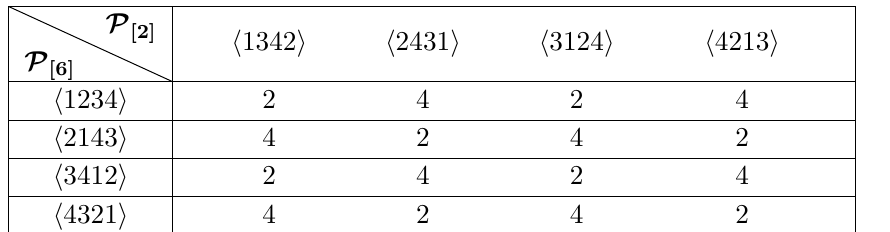
Table 8. {P} 6 − {P} 2 two-point correlator values.